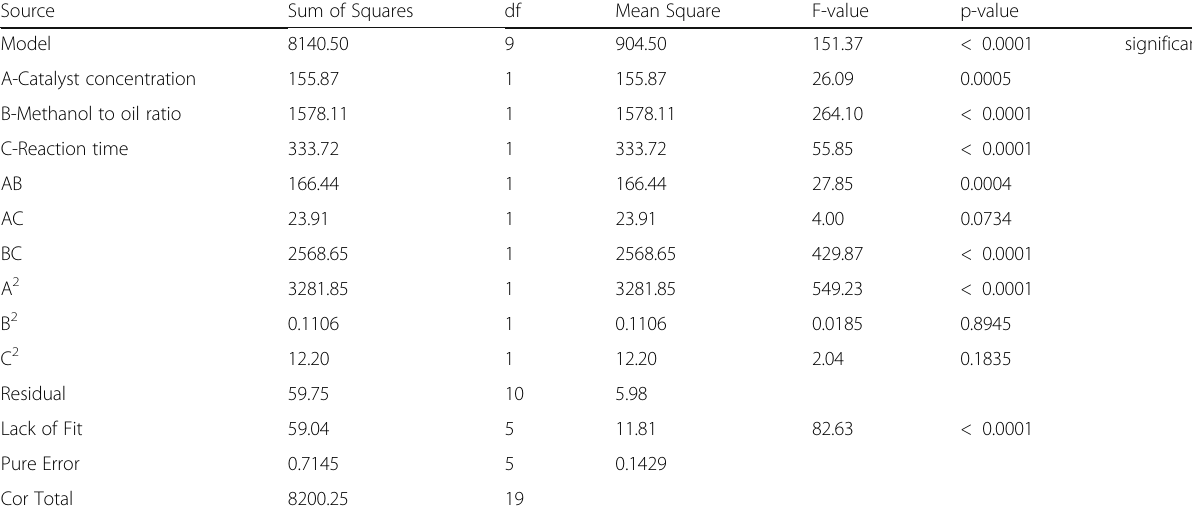
Table 5 ANOVA table for transesterification process